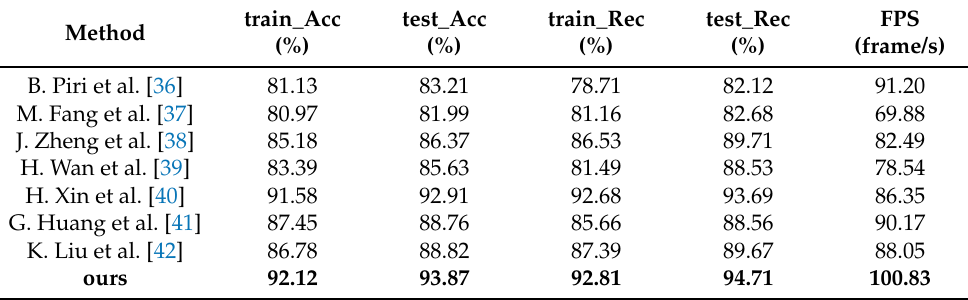
Table 2. Comparison of the indexes of this method and the latest experimental